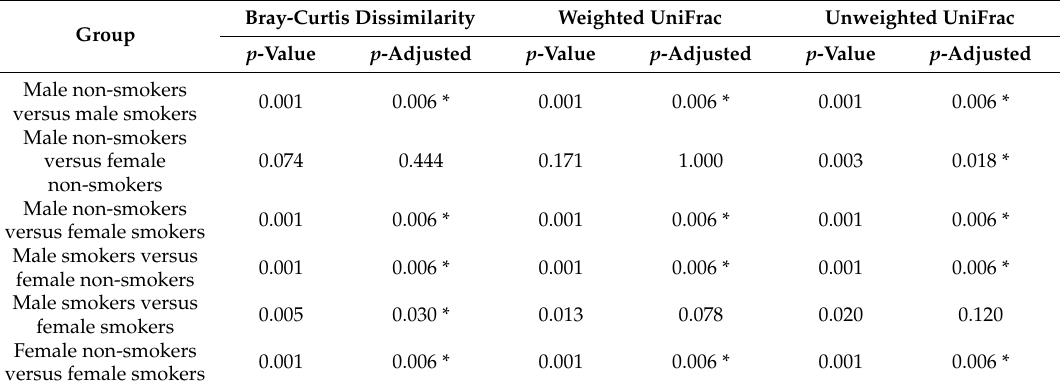
Table 2. The Principal Coordinates Analysis (PCoA) plots of the three beta diversity metrics were used (Bray-Curtis, Weighted UniFrac, and Unweighted UniFrac) measuring significant di ff erences in beta diversity. Bray-Curtis Group